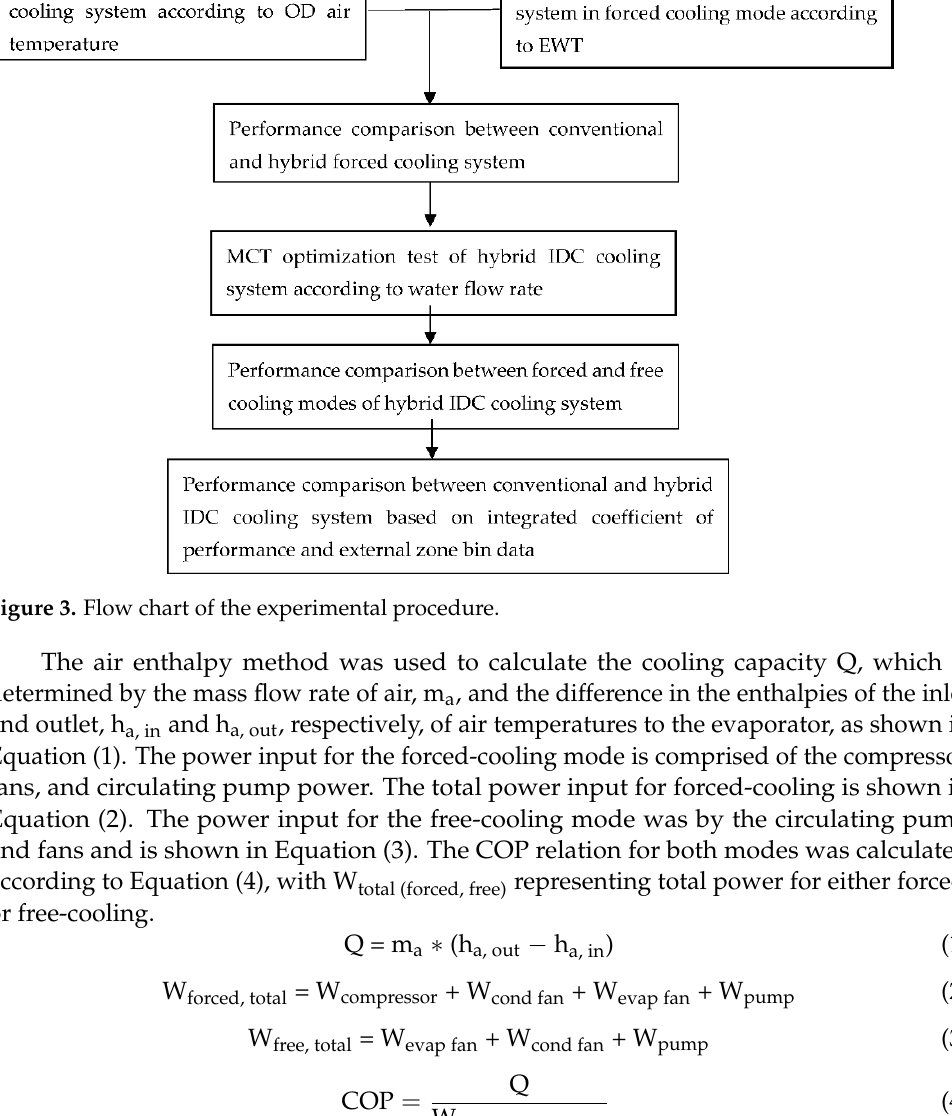
determined by the mass flow rate of air, m a , and the difference in the enthalpies of the inlet and outlet, h a, in and h a, out , respectively, of air temperatures to the evaporator, as shown in Equation (1). The power input for the forced-cooling mode is comprised of the compressor, fans, and circulating pump power. The total power input for forced-cooling is shown in Equation (2). The power input for the free-cooling mode was by the circulating pump and fans and is shown in Equation (3). The COP relation for both modes was calculated according to Equation (4), with W total (forced. free) representing total power for either forced- or free-cooling.